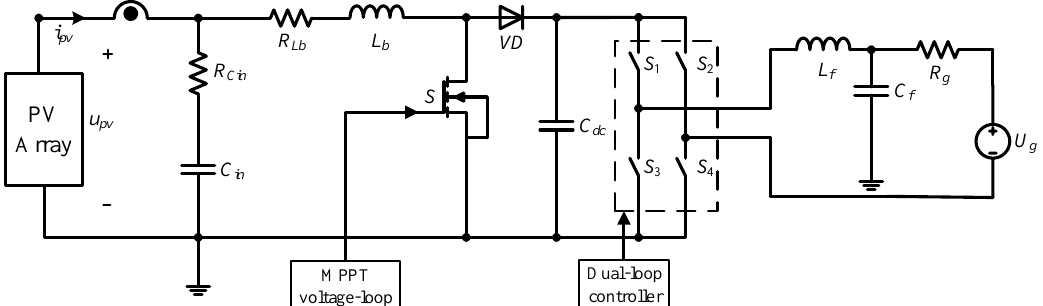
Figure 1. Cascade structure of a Two-Stage Grid-Connected photovoltaic (PV) system.